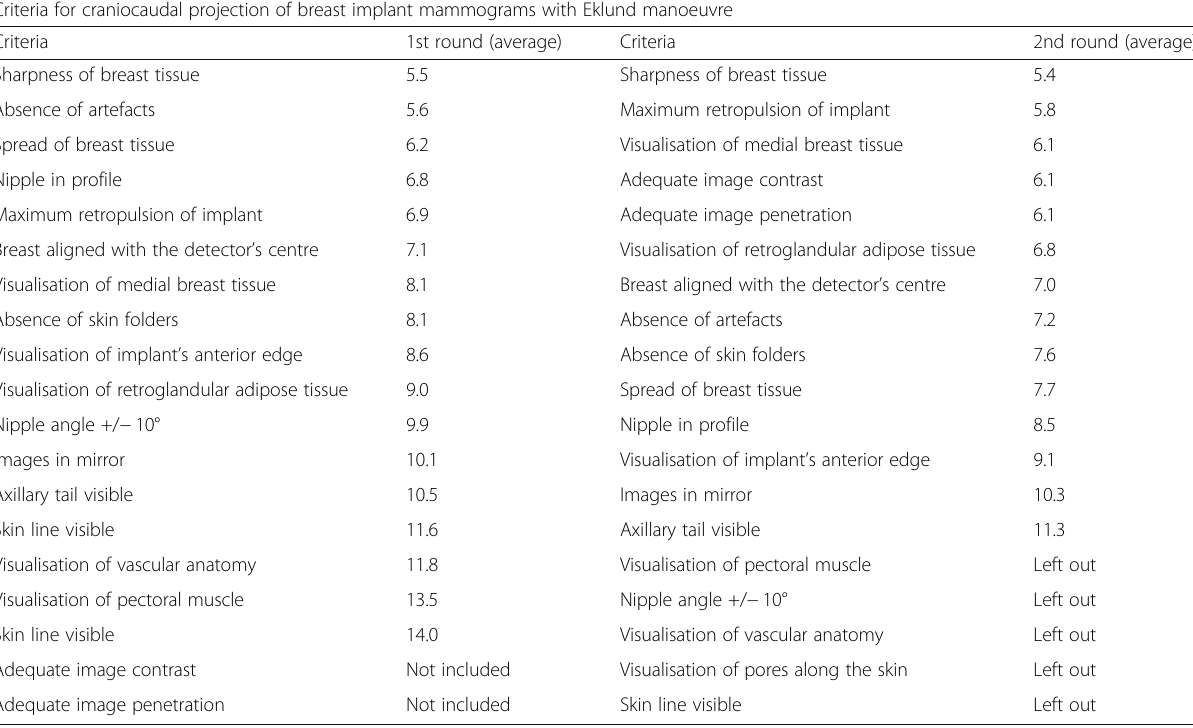
Table 4 Criteria raking (mean values based in Kendall ’ s W ) comparison between first and second Delphi rounds regarding craniocaudal images performed with Eklund manoeuvre combining the opinions of both groups (radiologists and radiographers) Criteria for craniocaudal projection of breast implant mammograms with Eklund manoeuvre